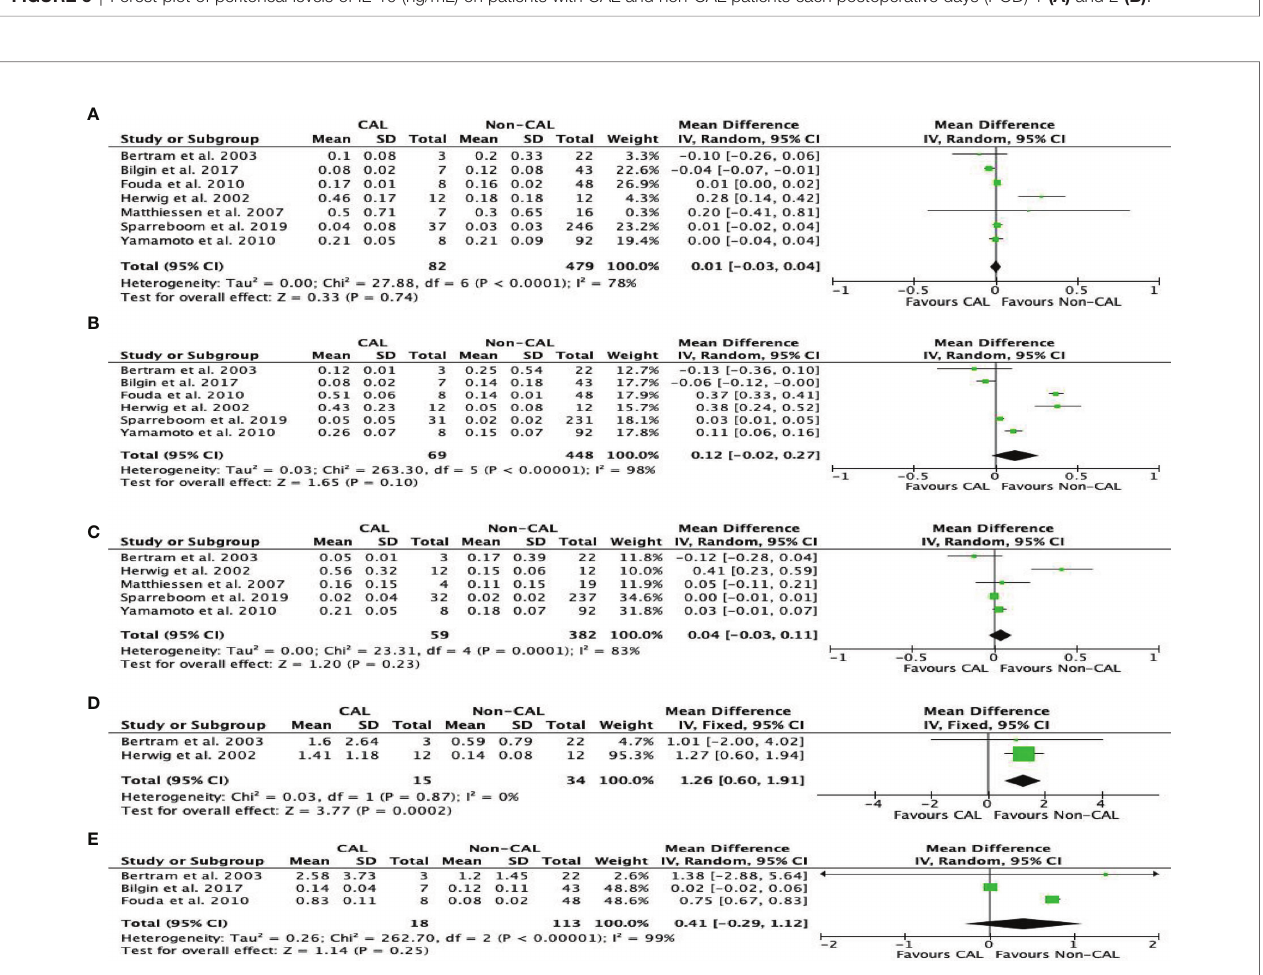
FIGURE 6 | Forest plot of peritoneal levels of TNF(ng/mL)onpatients with CAL andnon-CAL patients each postoperative days(POD) 1 (A) , 2 (B) , 3 (C) , 4 (D) and 5 (E)